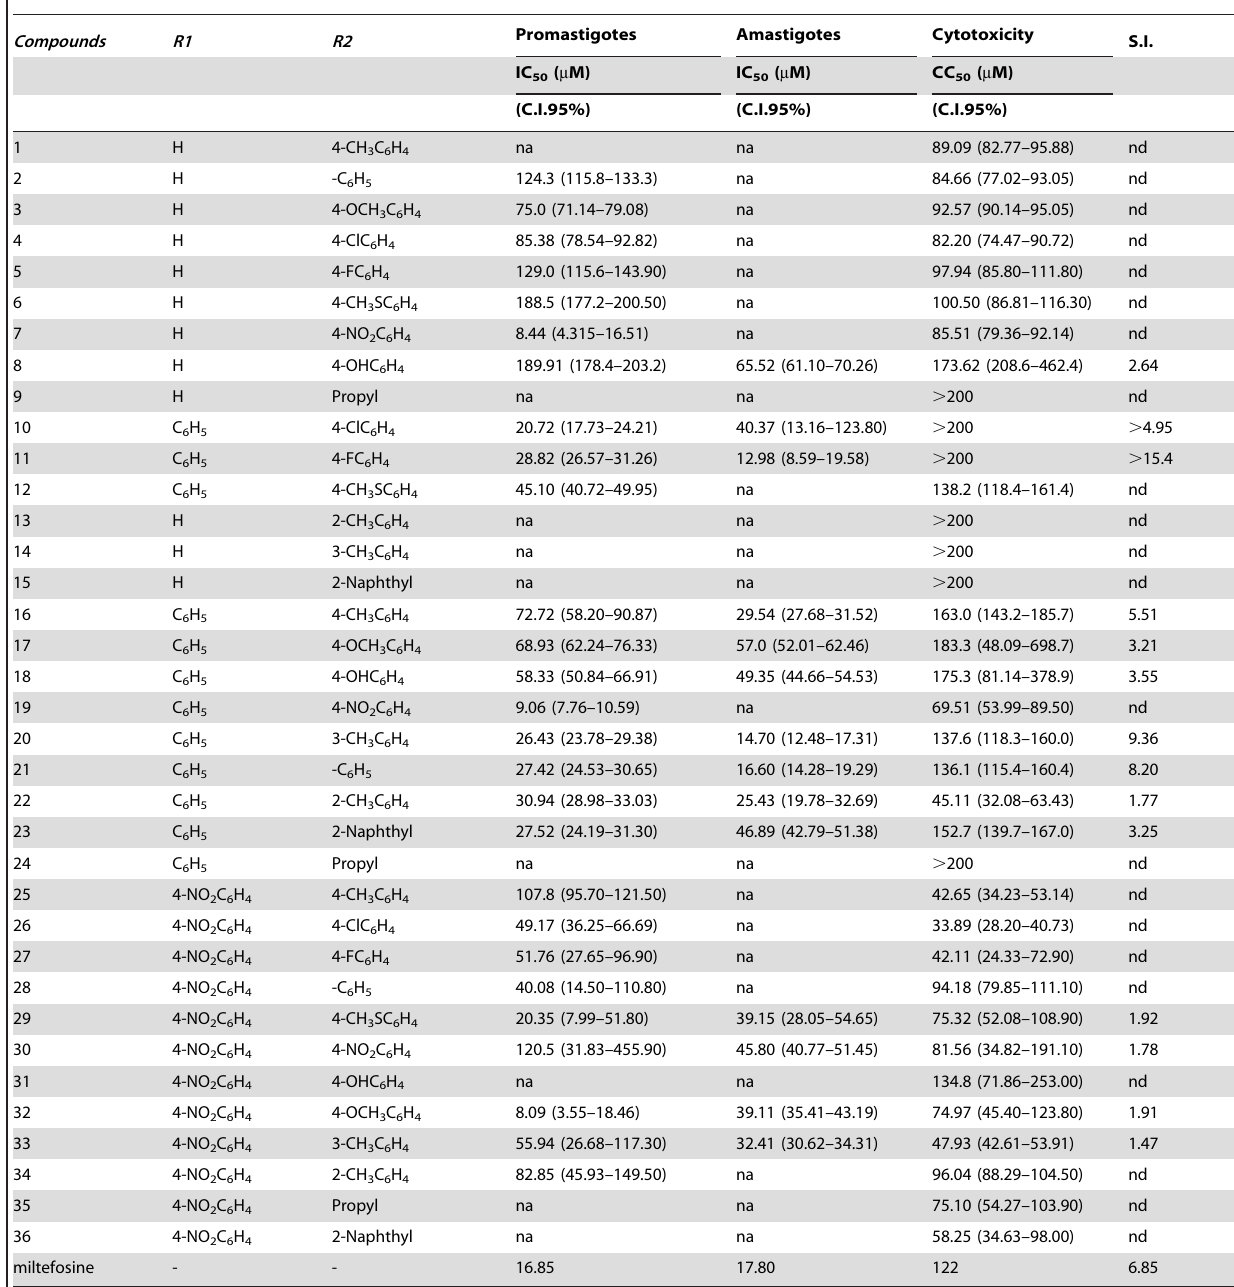
Table 1. Antileishmanial and cytotoxicity effects of 2-hydroxy-3-phenylsulfanylmethyl-[1,4]-naphthoquinones.